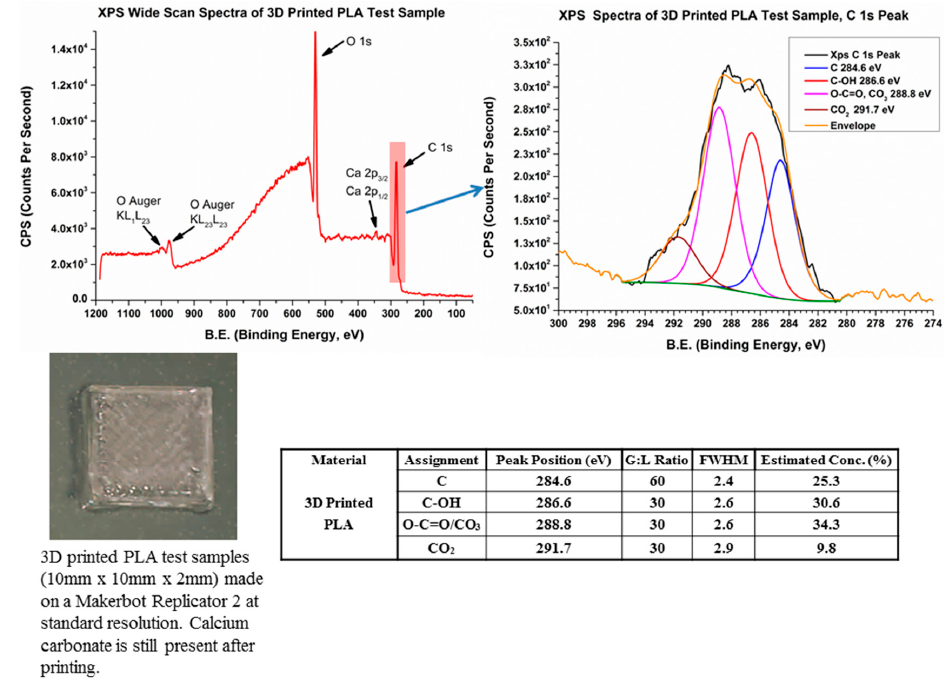
Figure 10. XPS spectra of 3-D printed PLA test samples, showing the wide scan spectra, and the analyzed C 1 s photoelectron peak, along with an image of the test sample analyzed by XPS.